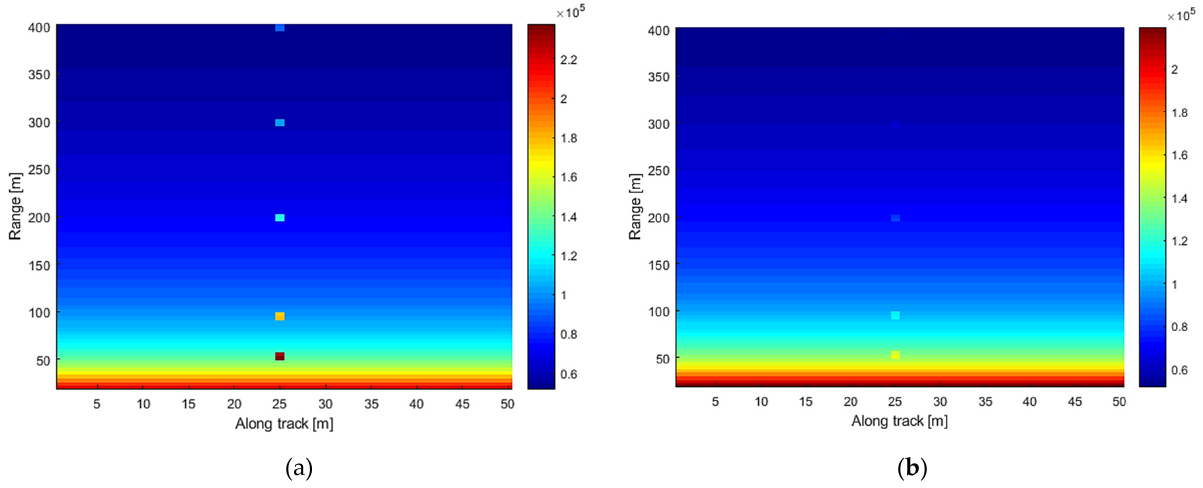
Figure 11. Simulated collected data along SAS of pipeline with leak bubbles: ( a ) Simulated data history of along-track and range; ( b ) simulated data history after pulse compression; ( c ) simulated data history after along-track compression.